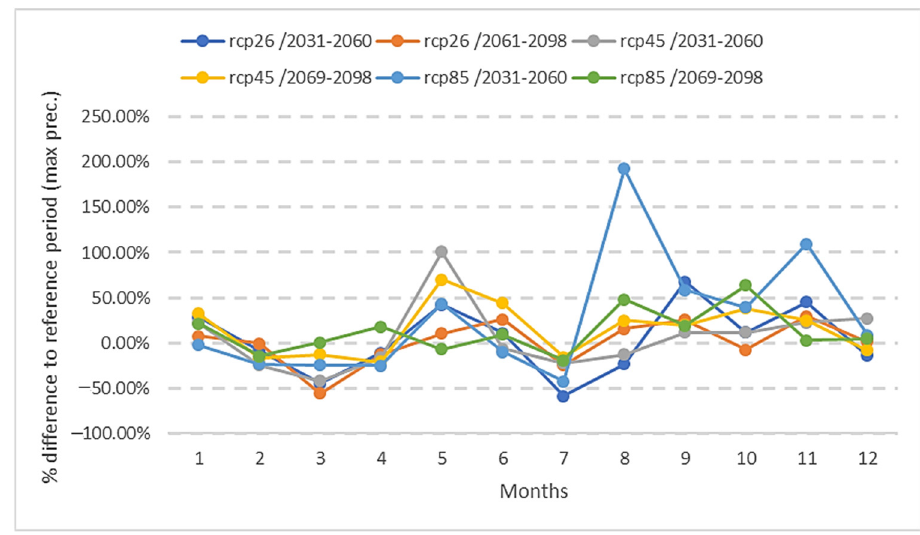
Figure 8. Percentage differences in mean maximum monthly rainfall for all climate scenarios relative to reference period mean maximum monthly rainfall.